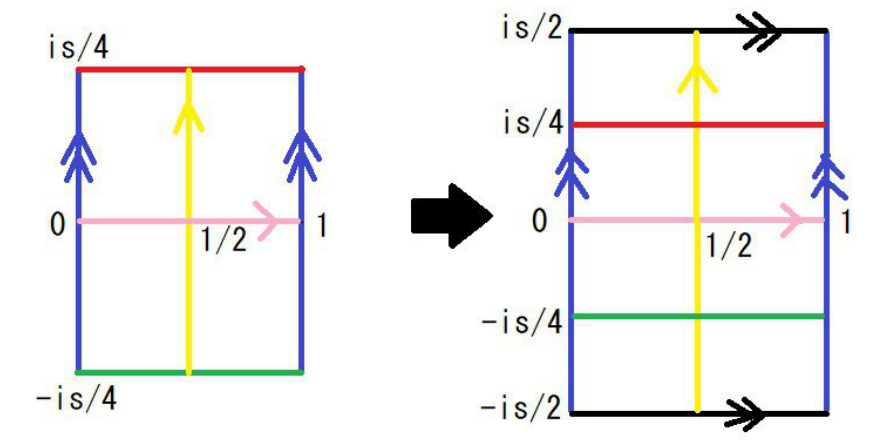
s= 2 line are (cid:6)